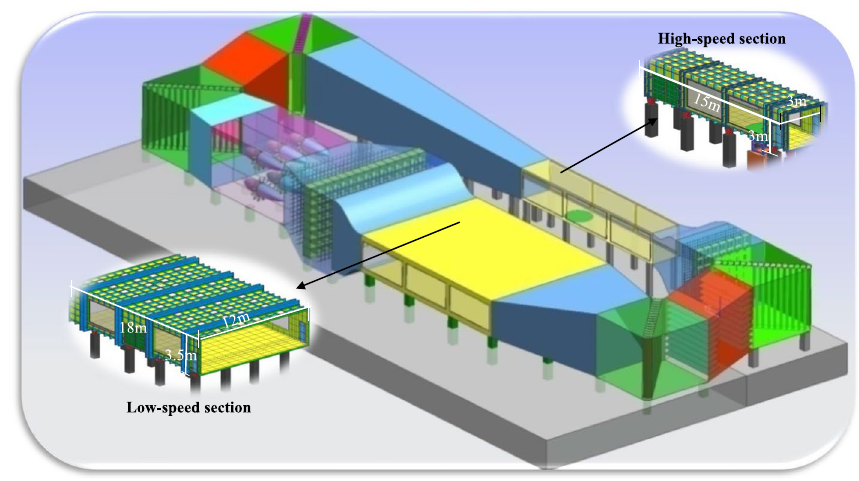
Fig. 2 Wind tunnel at Central South University (He and Zou